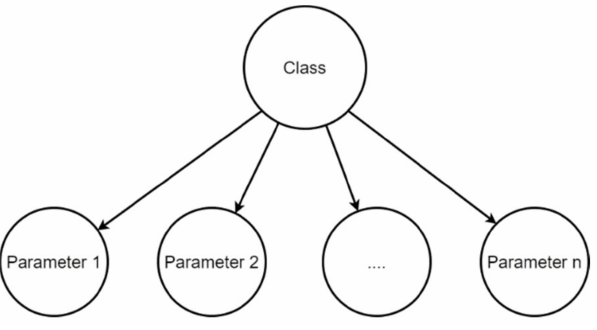
Figure 8. Naive Bayes